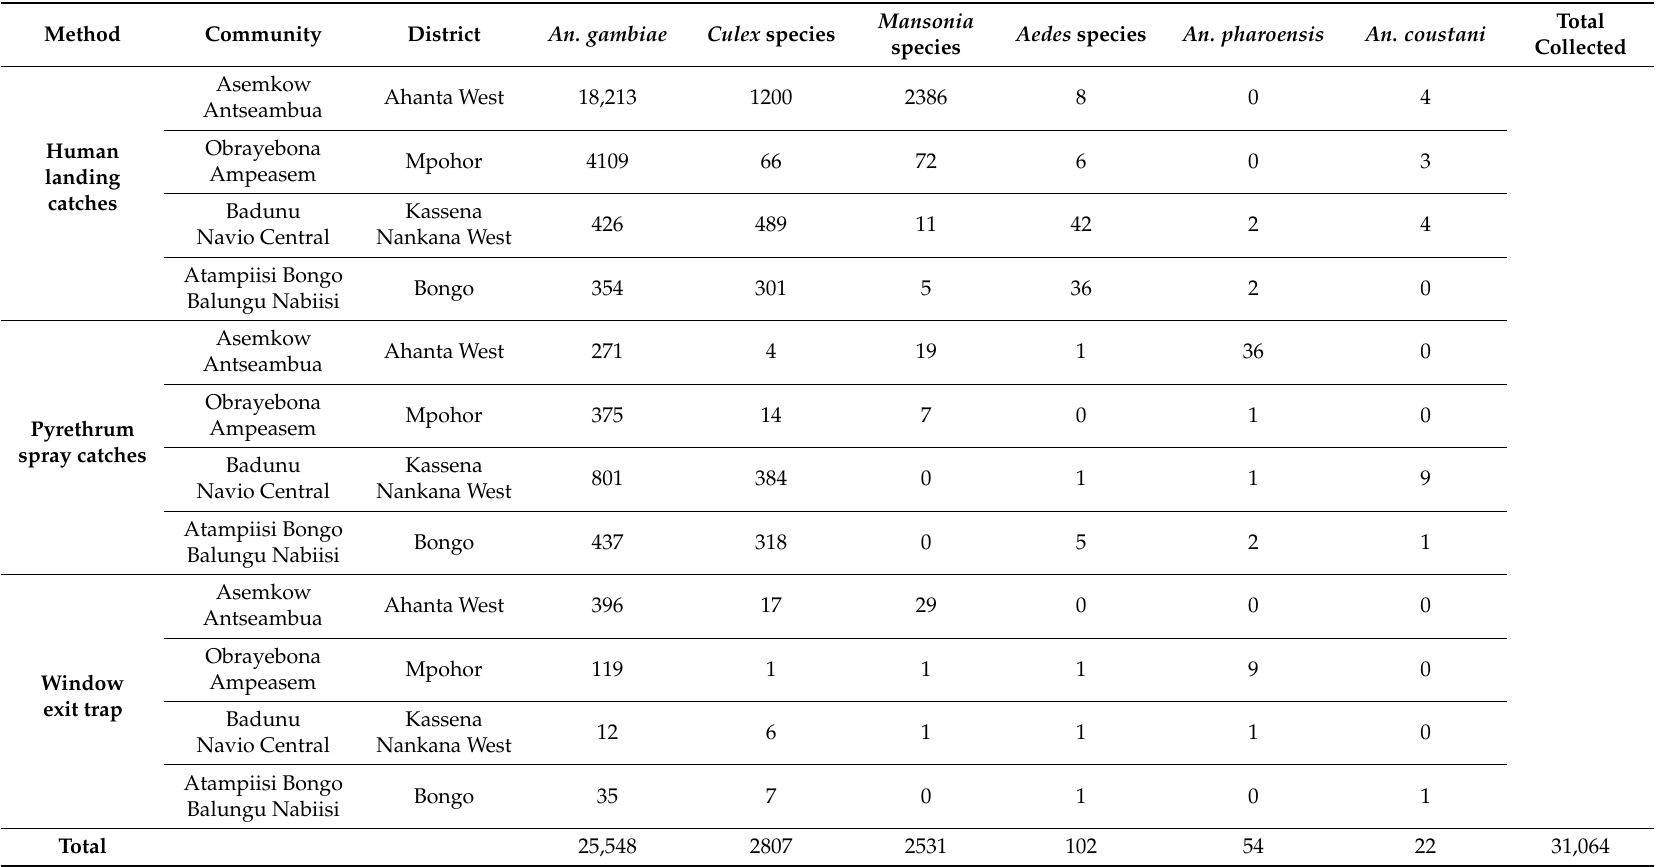
Table 2. Mosquitoes sampled using three different sampling methods from four study districts in Ghana during a 13-month sampling period between July 2015 and July